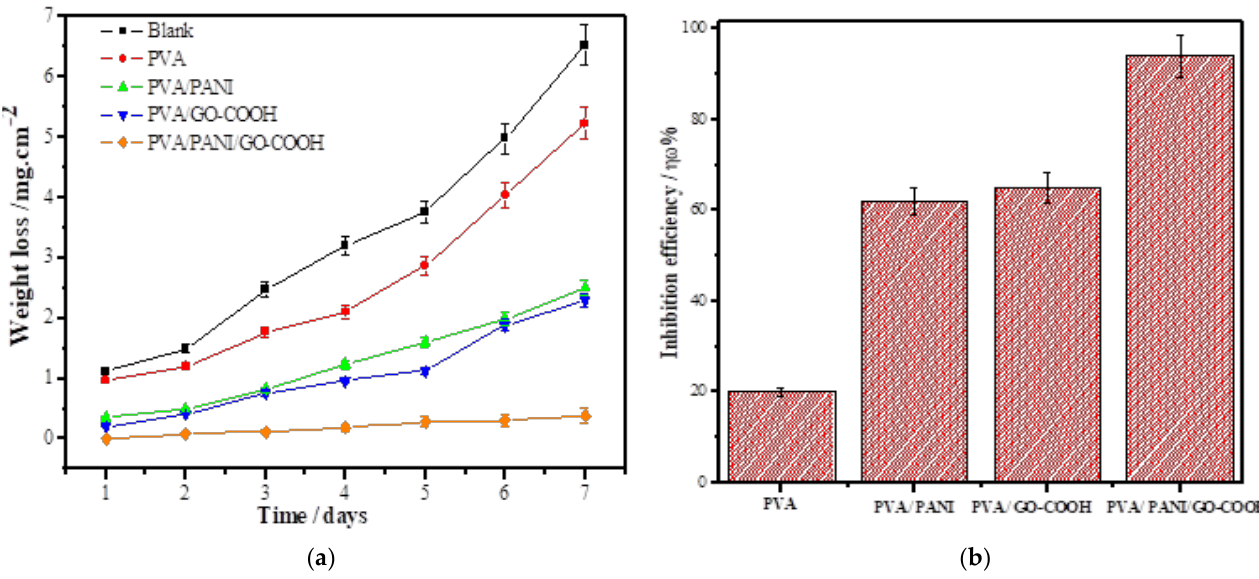
Figure 4. ( a ) Weight loss curves for cast iron in 3.5 wt.% NaCl solution, ( b ) inhibition efficiency, ηω %, in the absence and presence of various coatings.